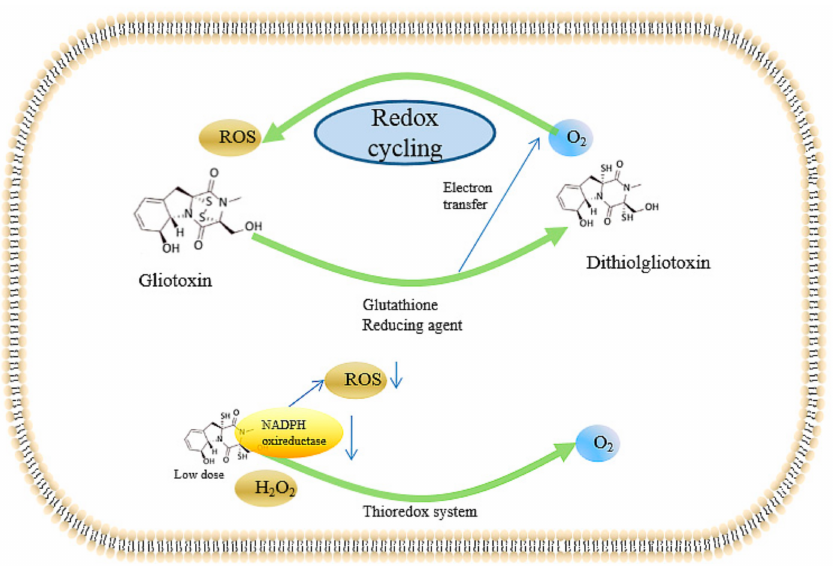
Figure 3. Gliotoxin-mediated redox cycling system and the antioxidant effect. The downward arrow indicates the ROS content was decreased by low dose of gliotoxin via the inhibition of NADPH oxireducatase activity in the presence of thioredox